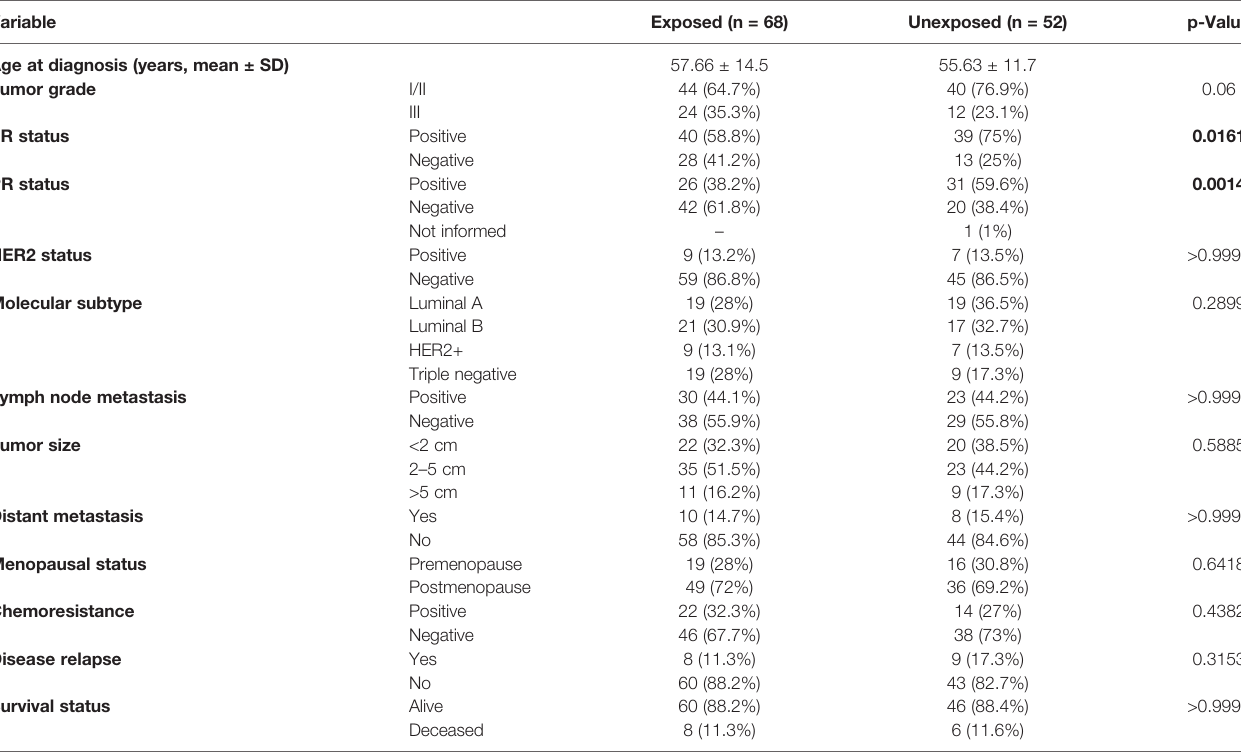
TABLE 1 | Comparison of selected characteristics of the 158 breast cancer patients exposed and unexposed to pesticides. Variable Age at diagnosis (years, mean ±